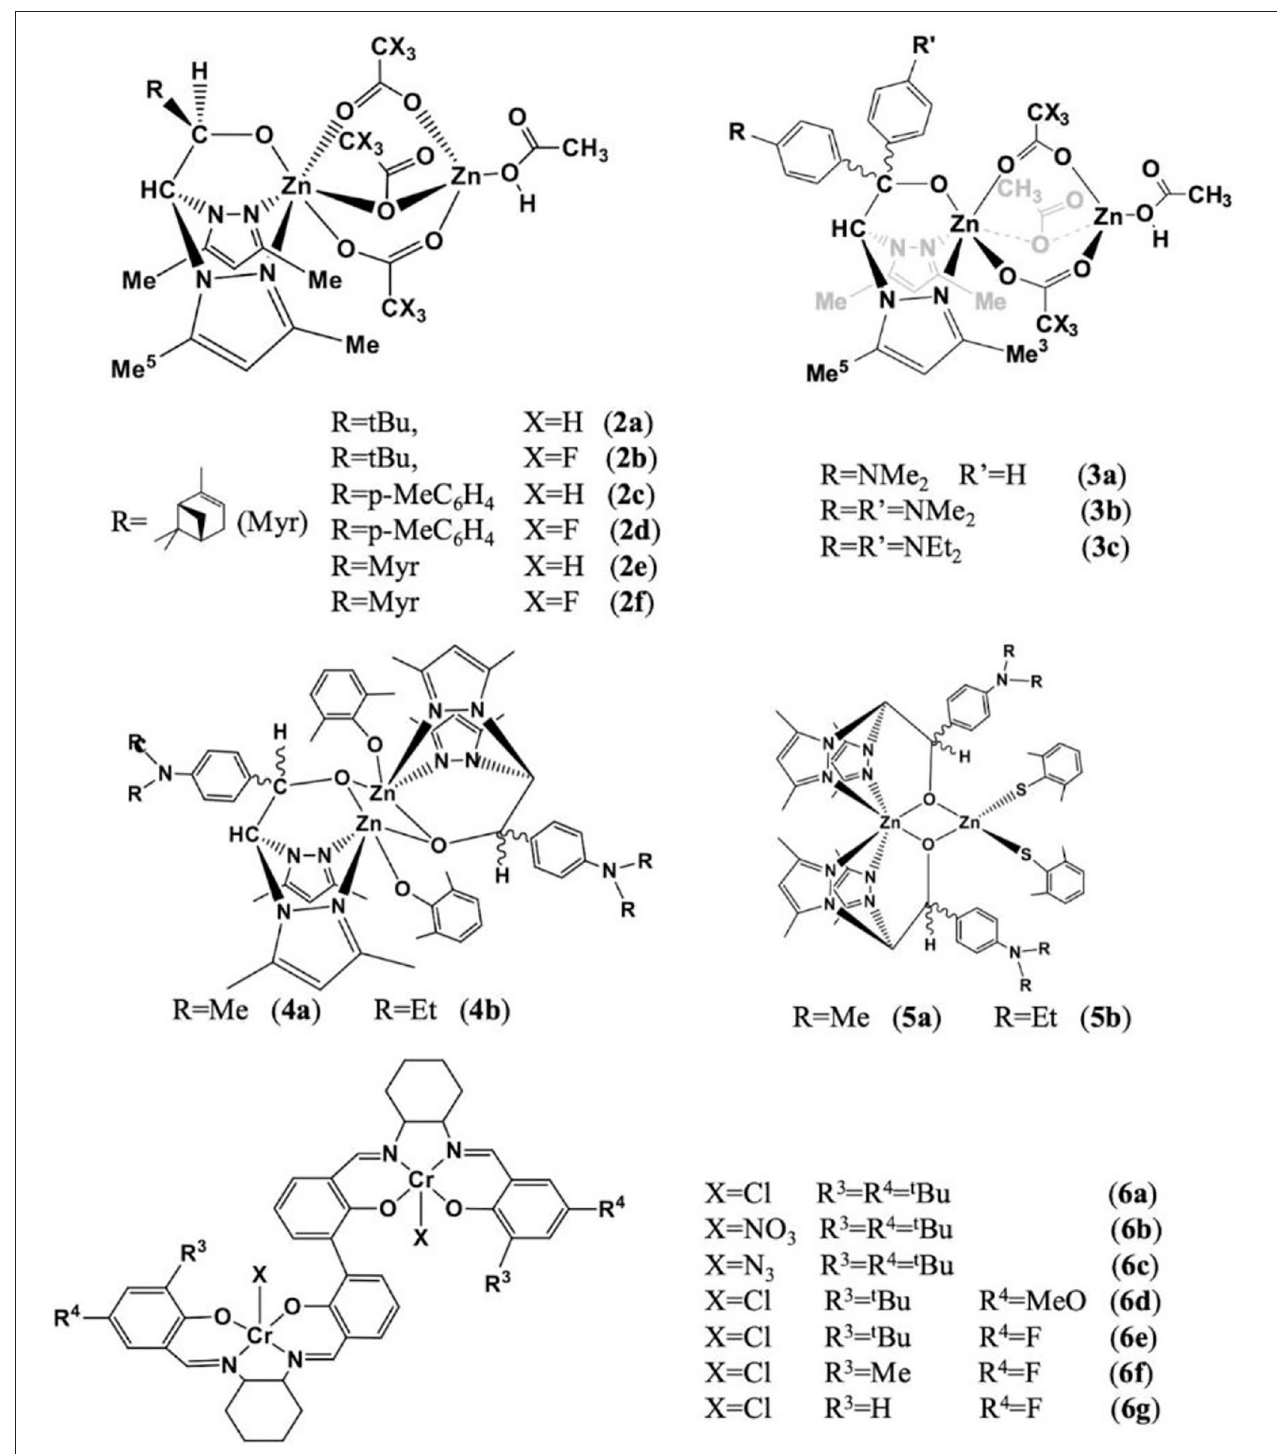
FIGURE 5 | The structures of the catalysts 2–6 based on scorpionate ligand. centers. The ROCOP of CO 2 and CHO was carried out under solvent-free, cocatalyst-free, optimal reaction temperature, and CO 2 pressure. It was found that all catalysts can initiate